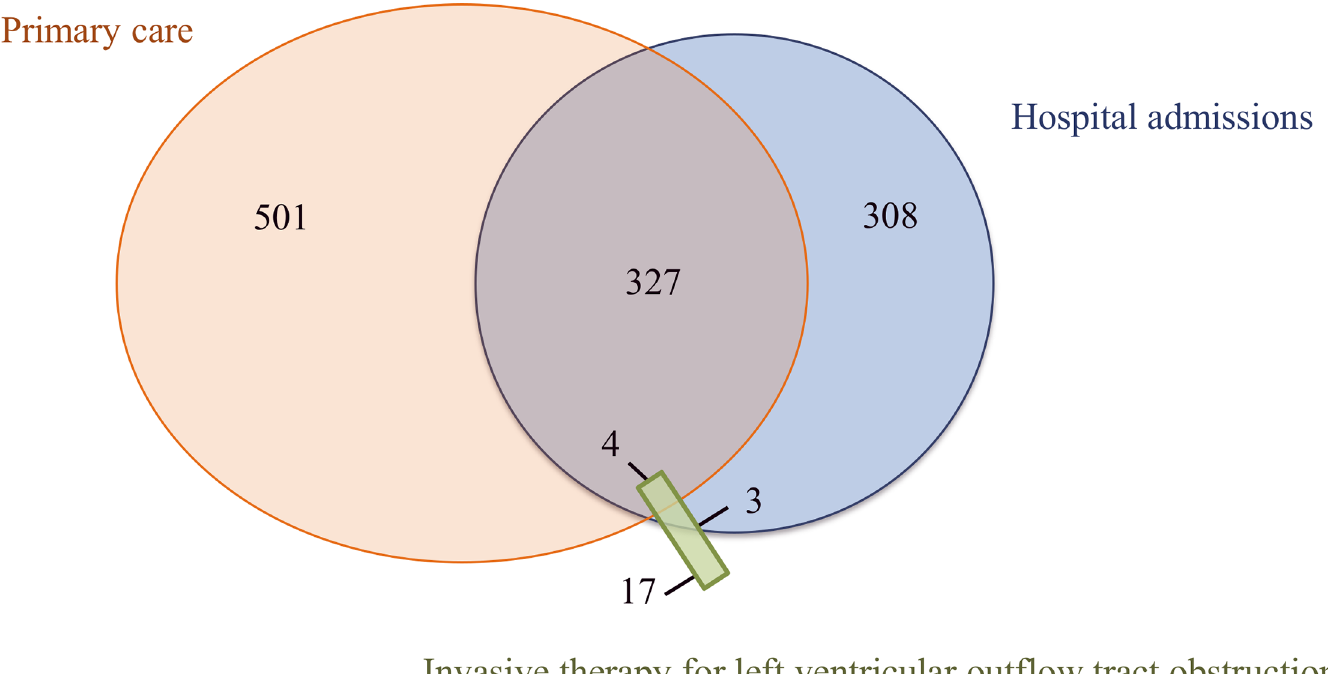
Fig 2. Capture of hypertrophic cardiomyopathy diagnosis in hospital admissions, primary care or both in a national sample of 5,372,790 people.